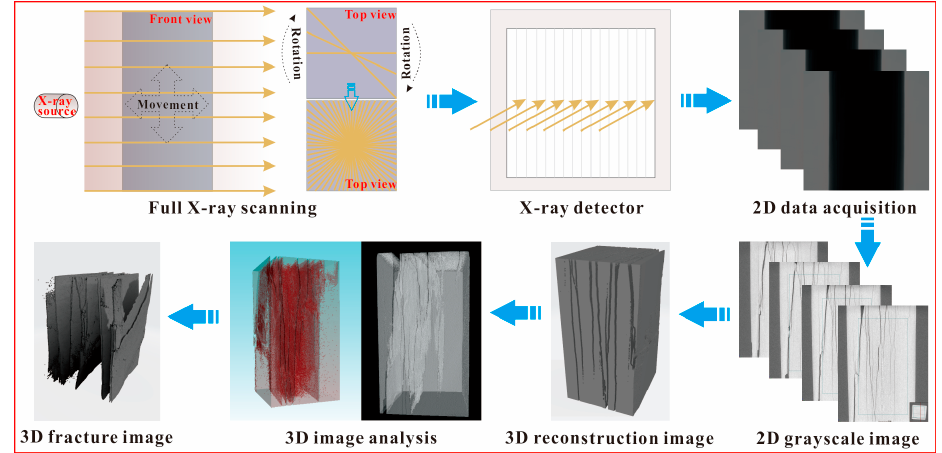
Figure 9. Schematic diagram of CT processing.